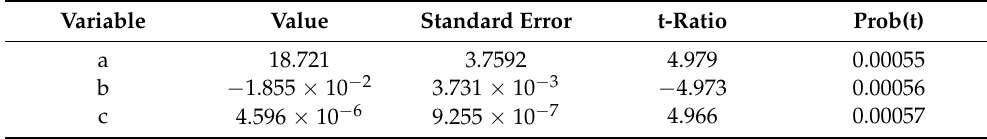
Table 6. Values of the coefficients of the mathematical model as a result of the regression for the considered data set.